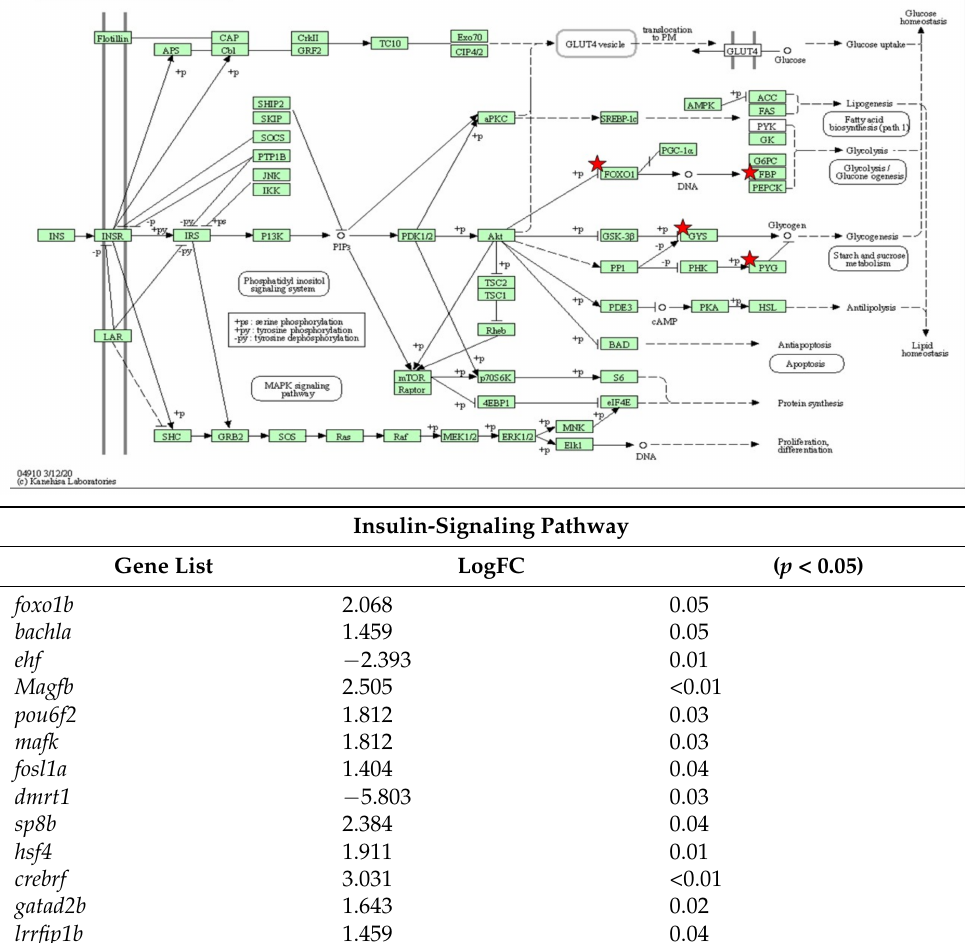
Table 4. The gene set enriched in insulin signaling and glucose metabolism in the DAVID platform. Insulin-signaling pathway associated with metabolic disorders depicted based on KEGG pathway with the significant differential expressions set enriched ( p < 0.05). The star (*) indicates the genes involved in the insulin-signaling pathways integrated with the Table